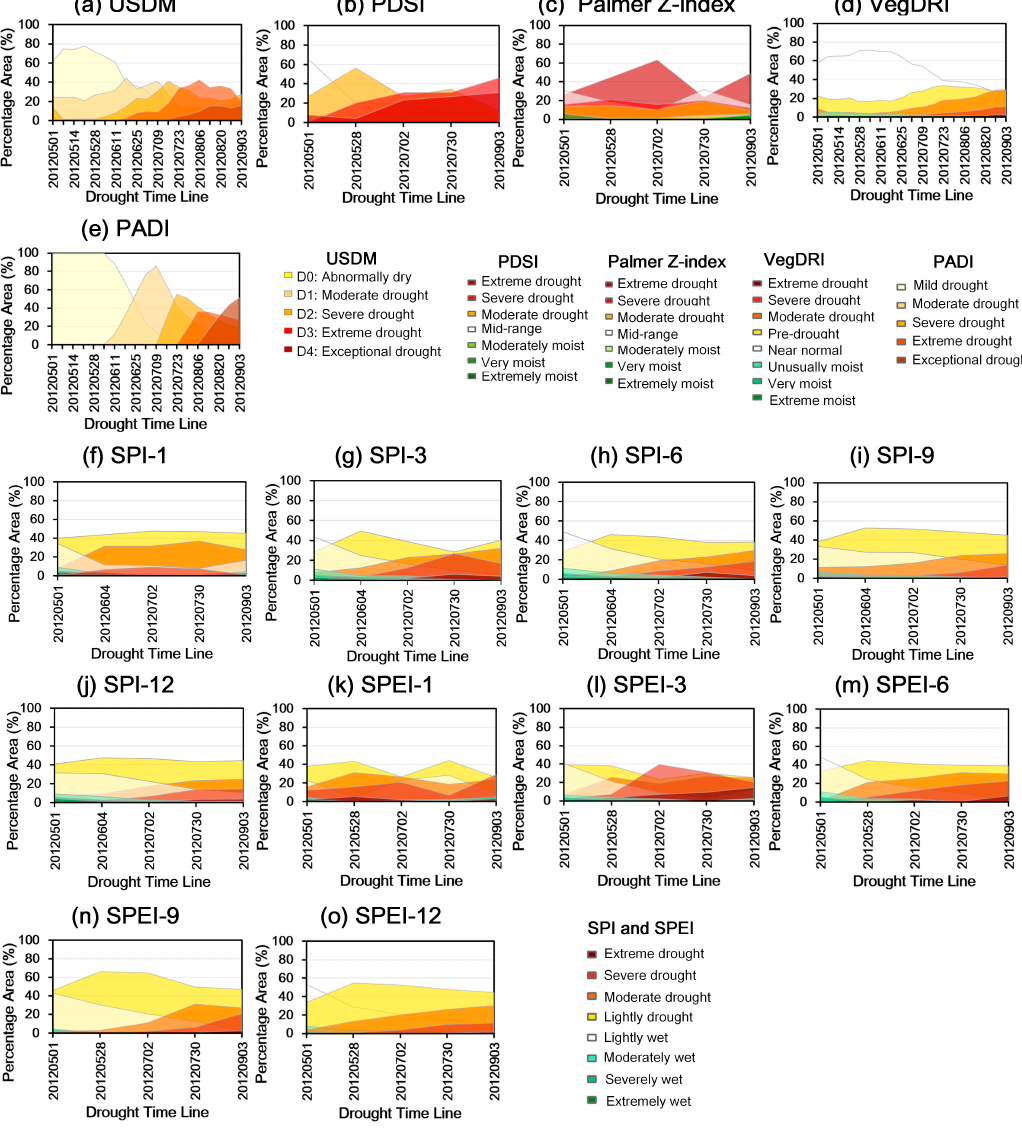
Figure 5. Percentage of drought categories of 2012 Midwest drought using different drought indices, including ( a ) USDM, ( b ) PDSI, ( c ) Palmer Z-index, ( d ) VegDRI, ( e ) PADI, ( f ) SPI-1, ( g ) SPI-3, ( h ) SPI-6, ( i ) SPI-9, ( j ) SPI-12, ( k ) SPEI-1, ( l ) SPEI-3, ( m ) SPEI-6, ( n ) SPEI-9, and ( o ) SPEI-12.